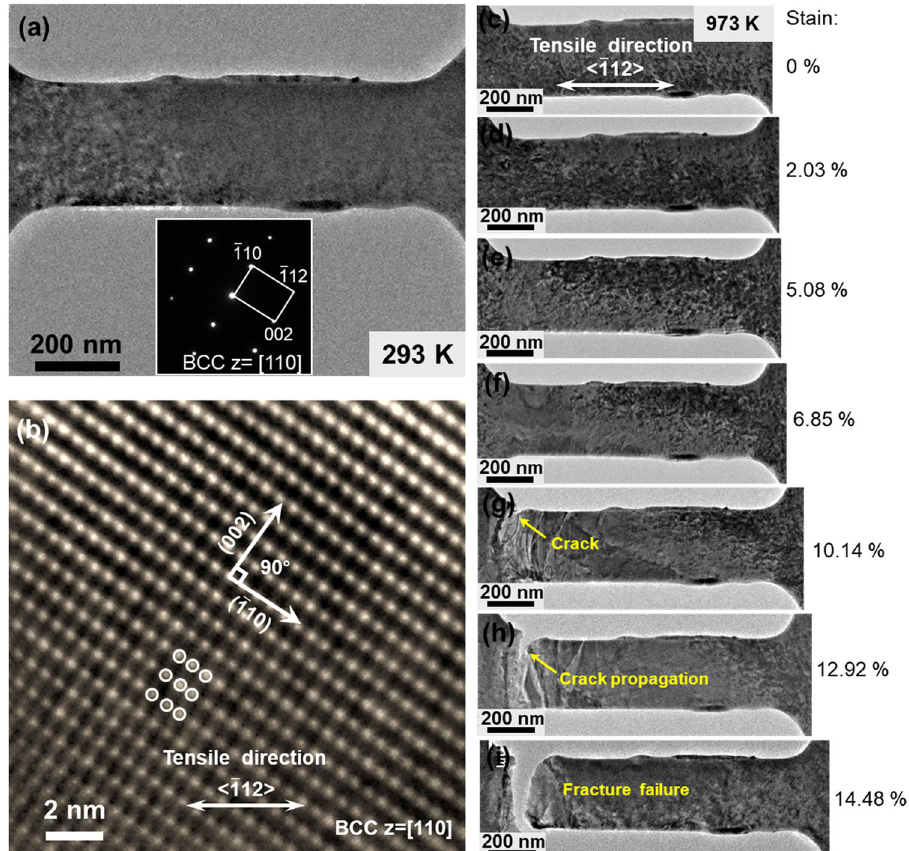
Fig. 2 In situ TEM observation of tensile fracture of W at 973 K. a A TEM image of a dog-bone shaped single-crystal W specimen fabricated by FIB. The inset is a selected area electron diffraction pattern of the specimen, revealing the [110] plane normal and the near [112] length directions. b High-resolution TEM image of the specimen at zero load. c – i Sequential TEM images of the specimen at different stages of the tensile deformation at 973